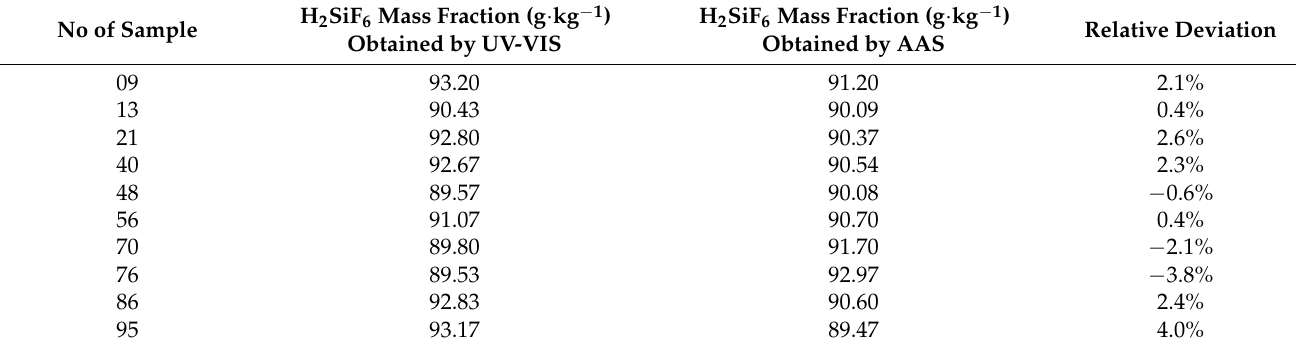
Table 5. Comparison of the H 2 SiF 6 mass fraction obtained by UV-VIS and